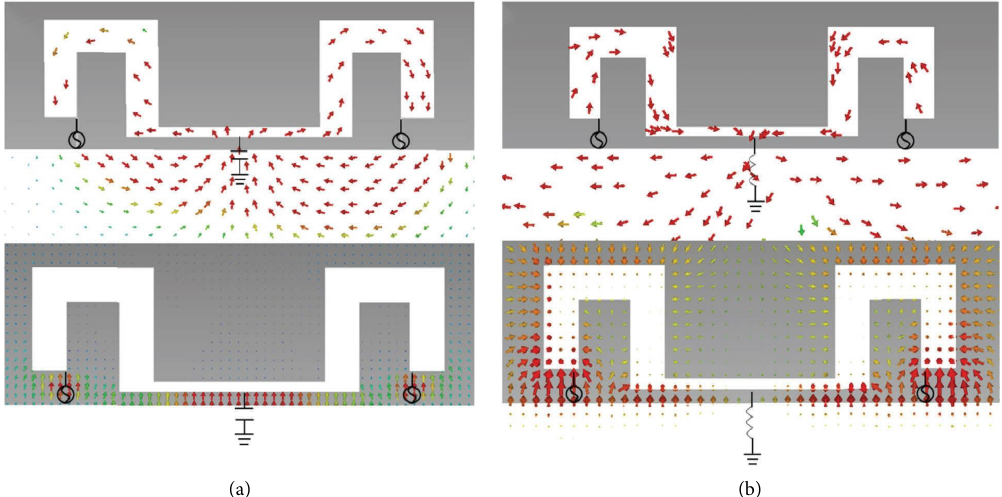
Figure 2: Surface current density and electric feld distribution of the proposed artifcial PMC decoupling structure. (a) C � 3 pF. (b) L � 11